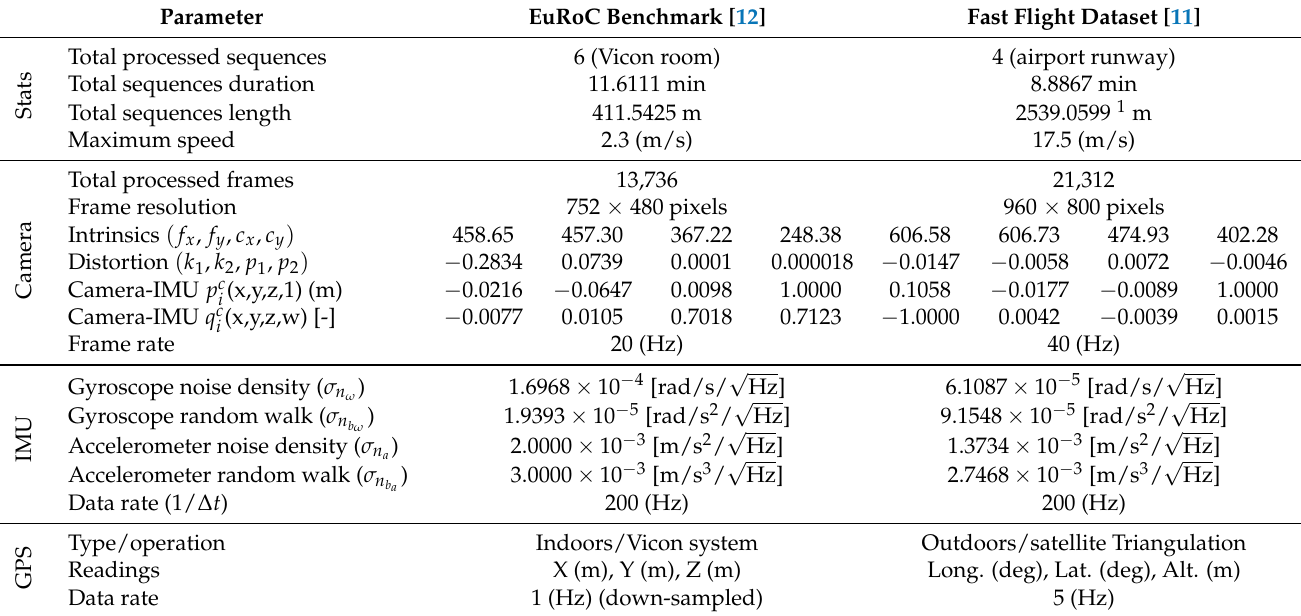
Table 1. Insights into our experiments’ statistical information and sensor settings.